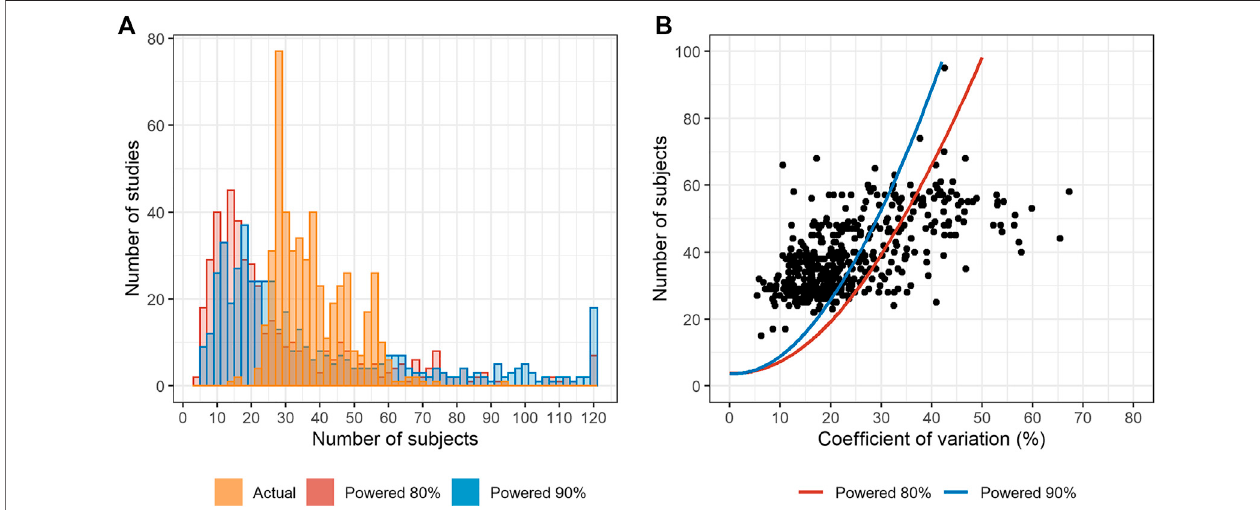
FIGURE 1 | The number of subjects compared with the estimated sample size. (A) Distribution ofthe actual and number of subjects with post-hoc estimation with 80 and 90%powers. (B) Maximum estimatedpost-hoc coef fi cient ofvariation (CV) vs. theactualnumber ofsubjects.Dots represent theactual number ofsubjects. The estimatednumbersofsubjectsarepresentedassolidlines.(Notes:Thestudiesinwhichtheestimatednumberofsubjectswas > 120,thenumberwasreducedto120for visualization. For fi xed-dose combination, the active pharmaceutical ingredient with the highest maximum CV was selected for analysis. Only 2 × 2 bioequivalence (BE) trials were